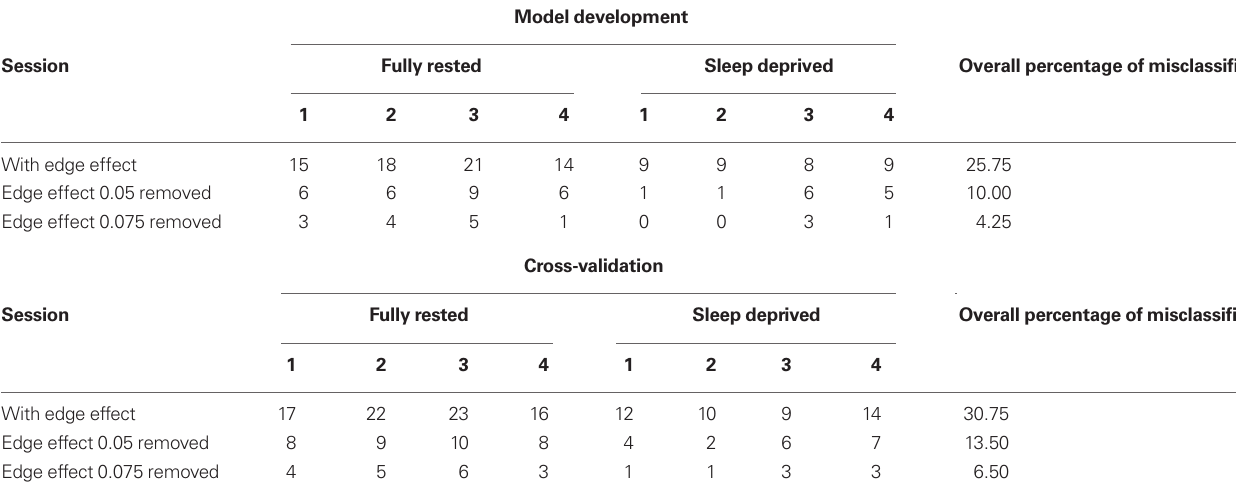
Table 5 | Number of misclassifications before and after edge effect